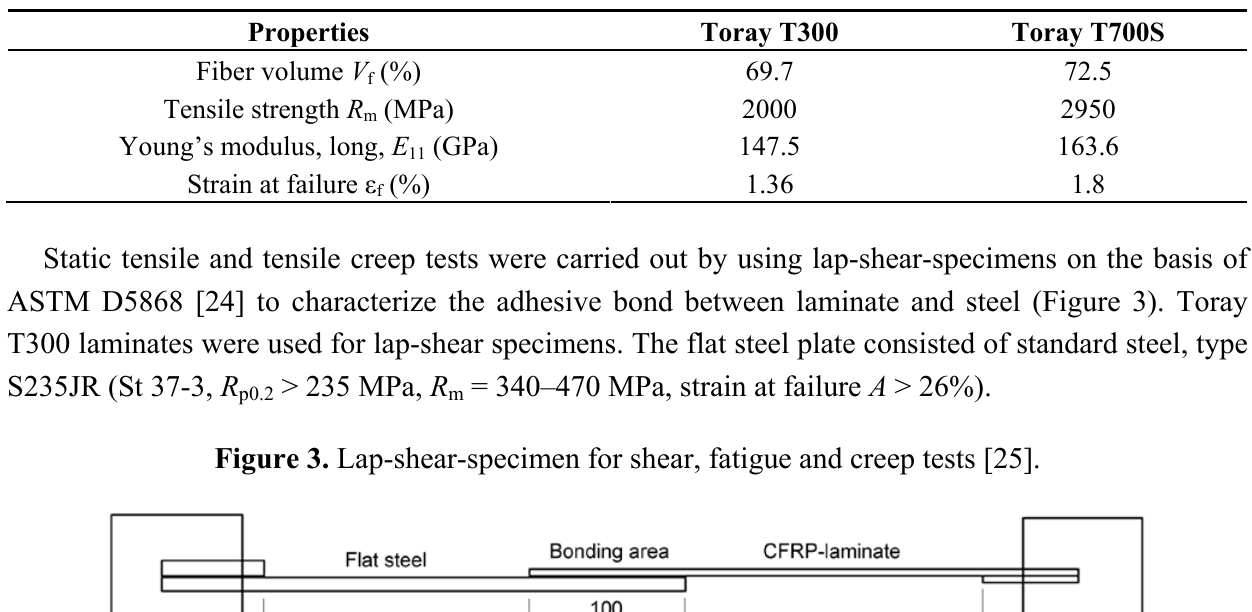
Table 1. Average of mechanical properties of carbon fiber reinforced polymer (CFRP) laminates (manufacturer).